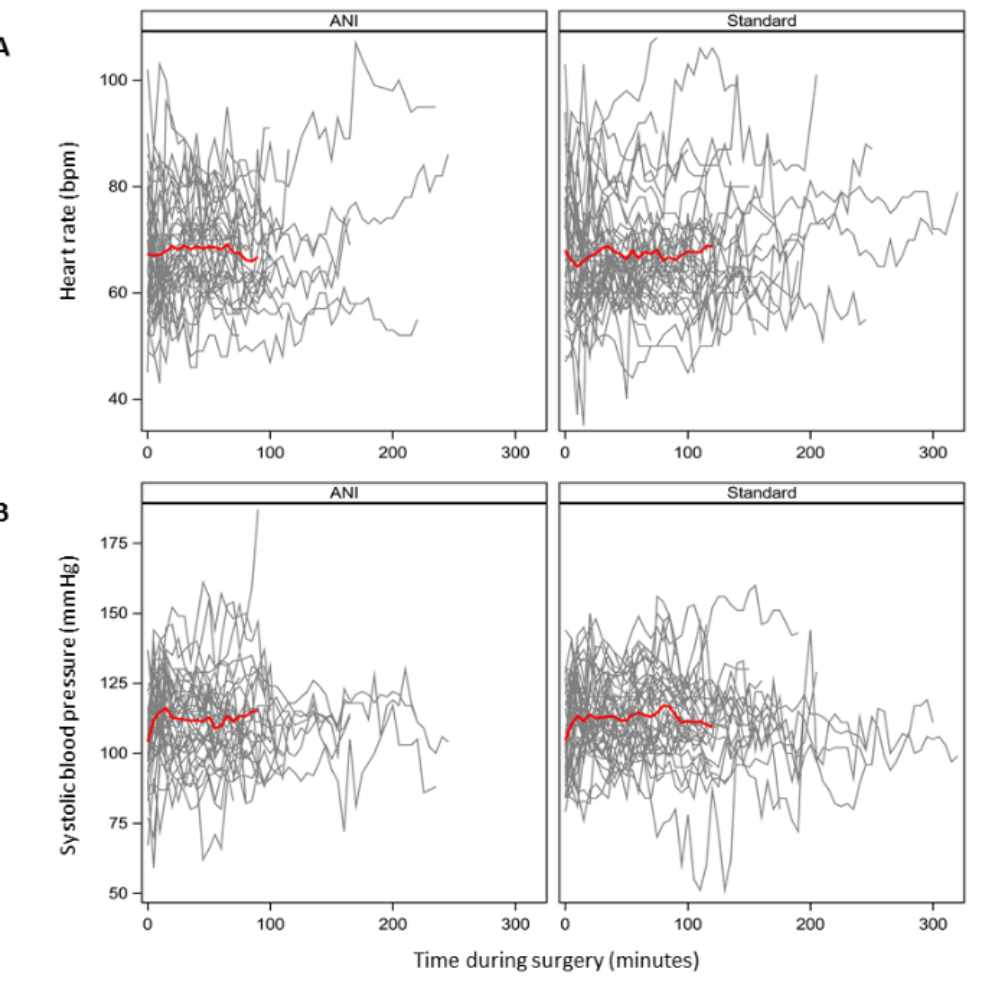
Figure 3. Individual evolution of heart rate ( A ) and systolic blood pressure ( B ) in the ANI group (38 lines; left ) and Standard group (40 lines; right ). Each line represents a patient. Red lines represent the